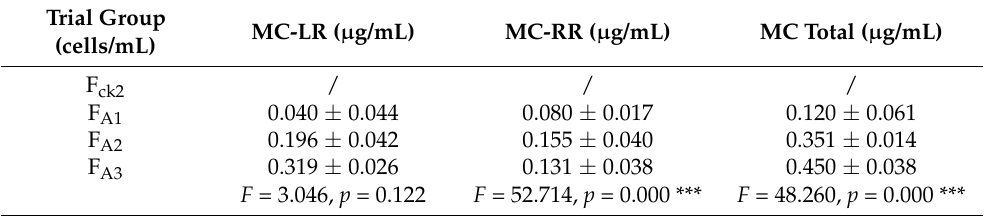
Table 3. ANOVA test and MC contents of M. macrocopa among different experimental groups. Trial Group MC-LR ( µ g/mL) (cells/mL)